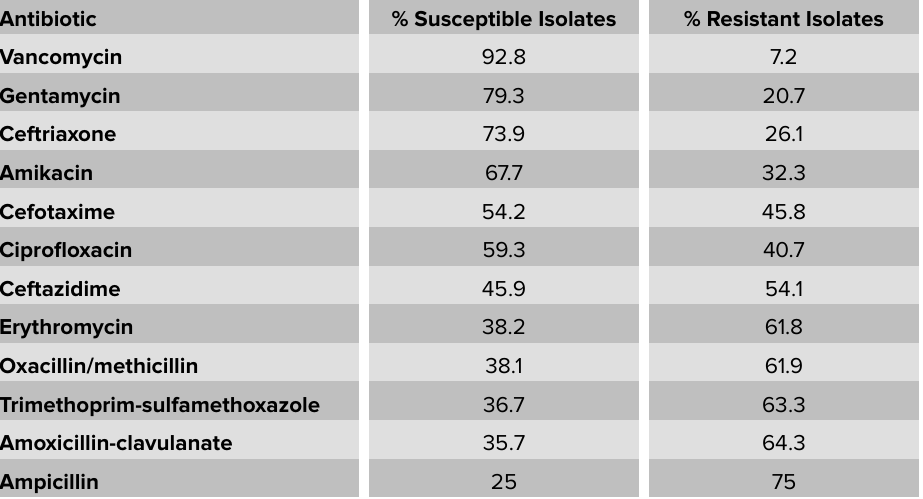
Table 1: Antibiotic susceptibility pattern among Gram-positive isolates.